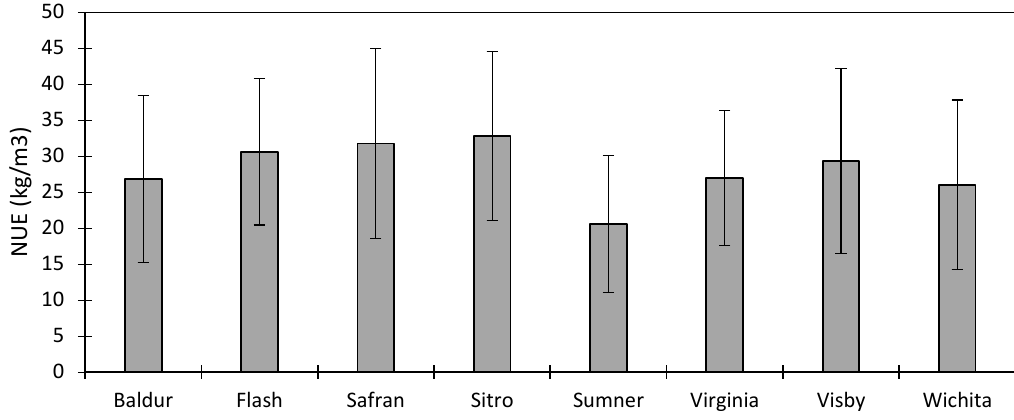
Figure 6. Average and standard deviation of winter canola seed yield.